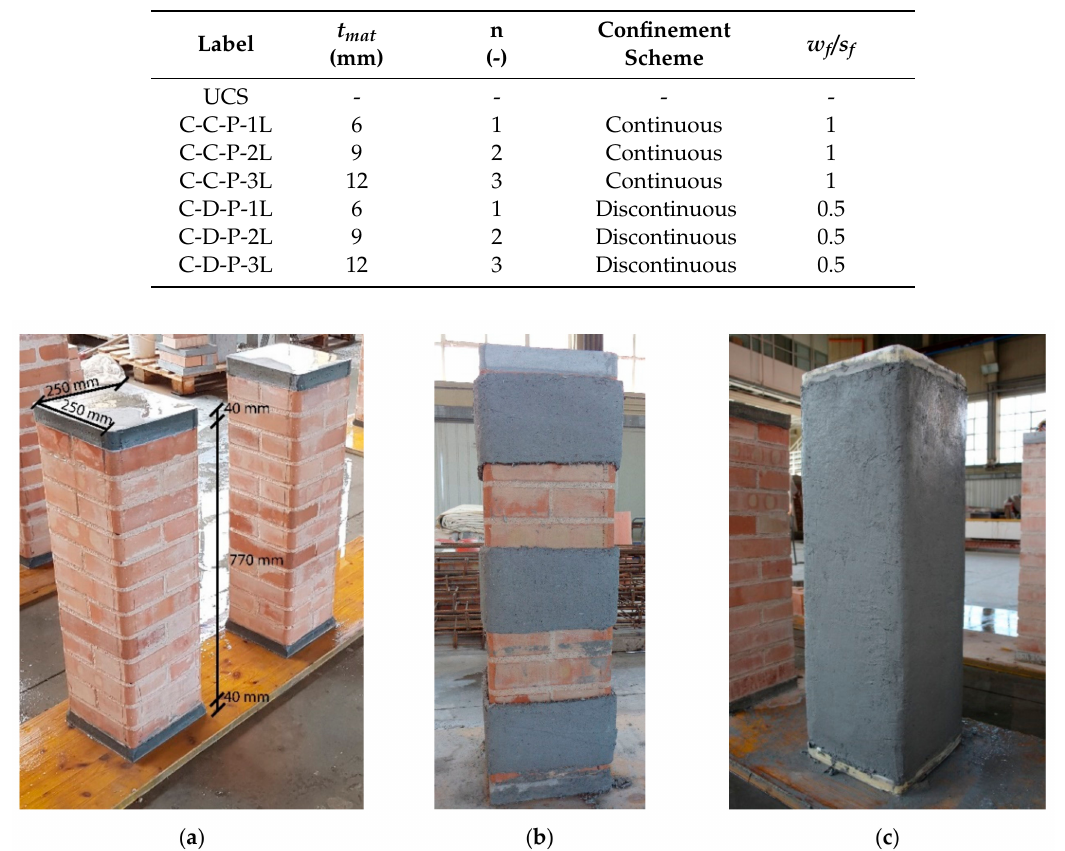
Figure1. Smallscalecolumn: ( a )geometry,( b )discontinuousconfinement,and( c